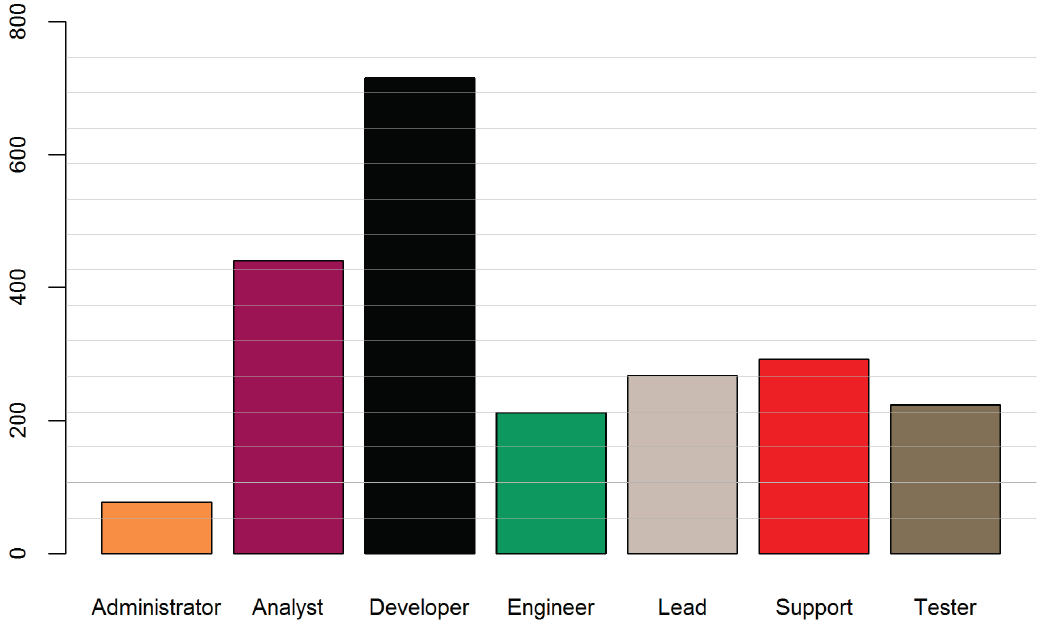
Figure 10. Distribution of predictions (unseen